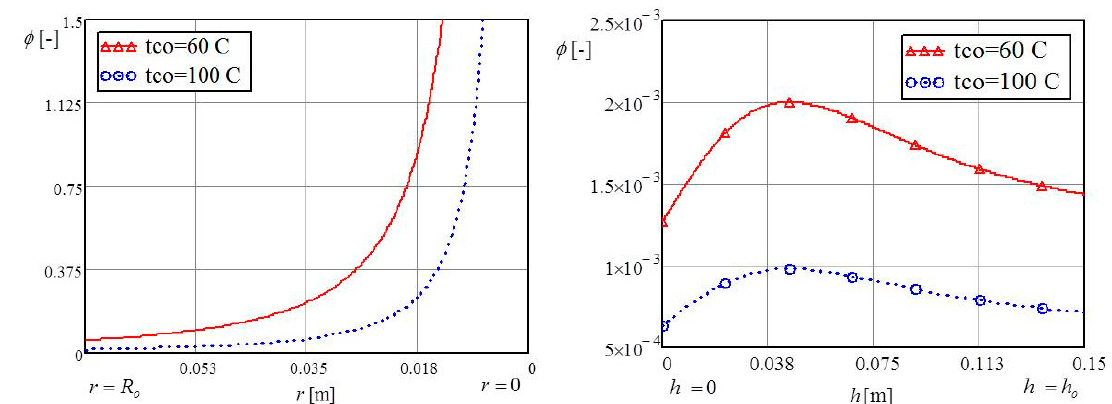
Figure 12. Irreversibility distribution ratio of the individual influence of the bottom and the vertical annular channel.